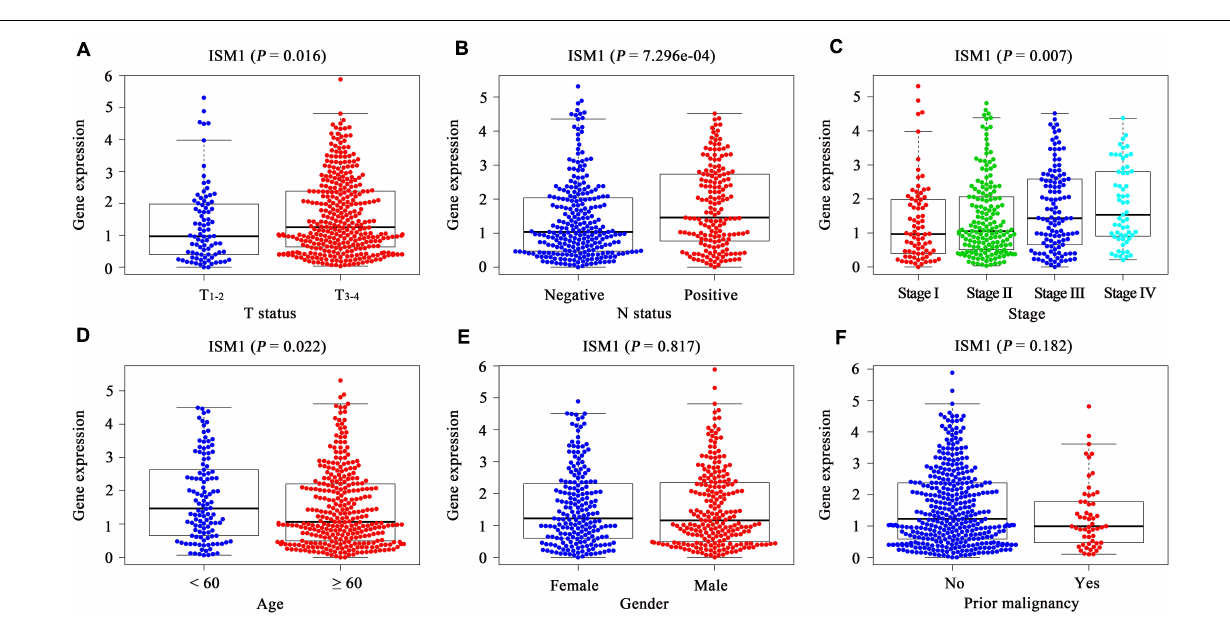
bovine serum (FBS, Gibco). All cell lines were cultured in a 37 ◦